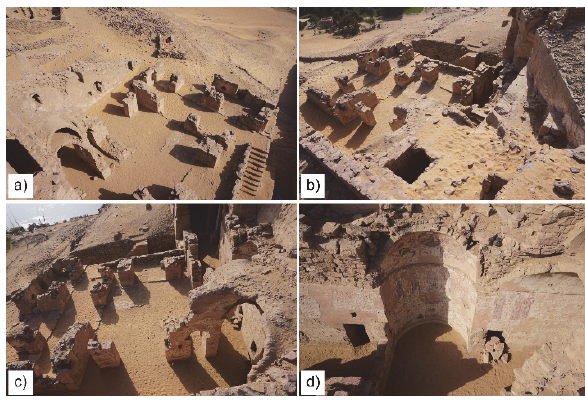
Figure 2. Views of the Qubbet el-Hawa Coptic Church ruins: a) north part; b) southeast part; c) south part; d) apse